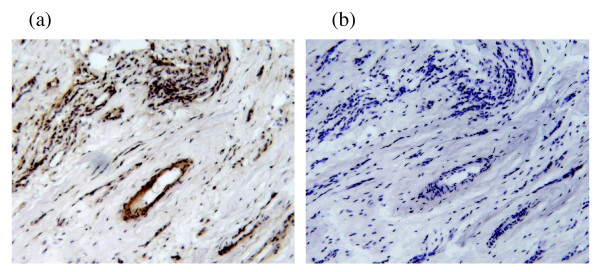
Intense staining for CCL5 on endothelium within inflamed synovial tissue of juvenile idiopathic arthritis patients. Immuno-staining for (a) CCL5 on synovial biopsy tissue taken from a child with oligoarticular juvenile idiopathic arthritis, carried out on a frozen section by standard immunohistochemistry for (b) CCL5 or with isotype control (both images 100×). CCL5 is seen to be expressed on endothelial cells and infiltrating inflammatory cells.